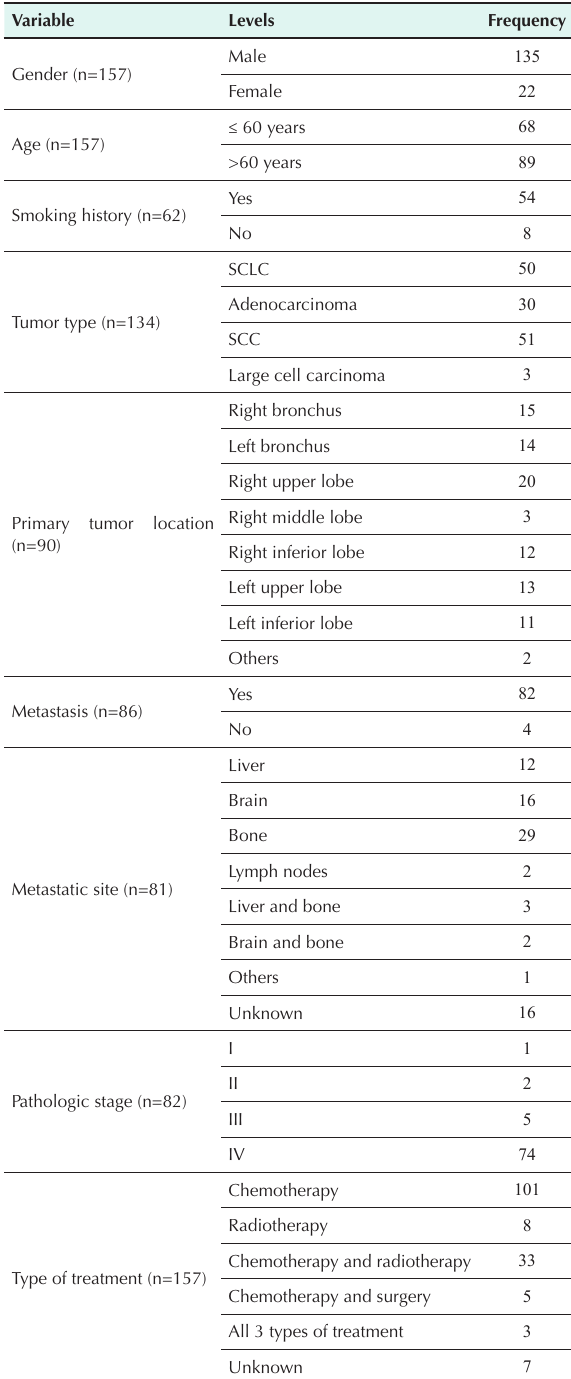
Table 1 . Demographic Characteristics and Tumor Status of Patients with Lung Cancer